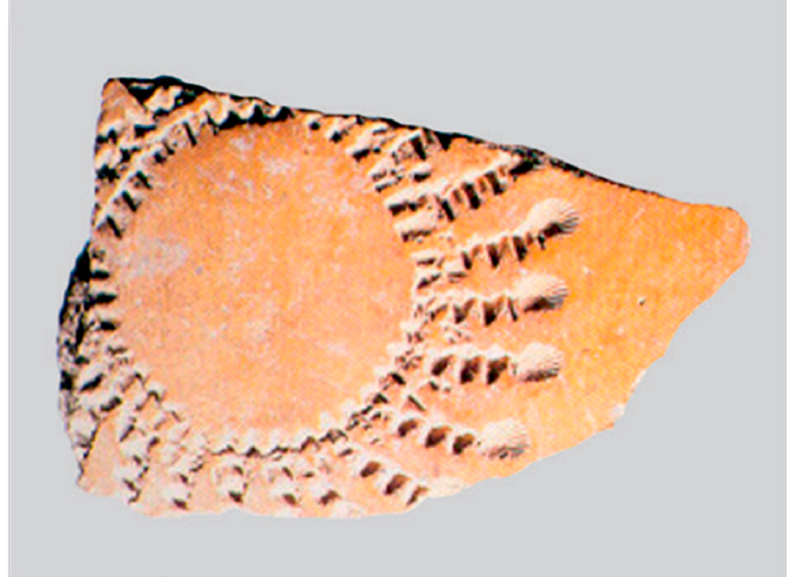
Figure 2. Printed “cardial” cup from the Cova de l’Or. Photography: Museu de Prehistòria de València. These circles may be connected to the sun, as shown by the soliform figures on some ceramics, such as the fragment in the Museum of Prehistory in Valencia—this is shown as Figure 3 (Hernández Pérez et al. 1988, pp. 292–93) In another ceramic appears a diagram with the circle and the triangle that is in its interior, indicative of the “femininity” of the sun.